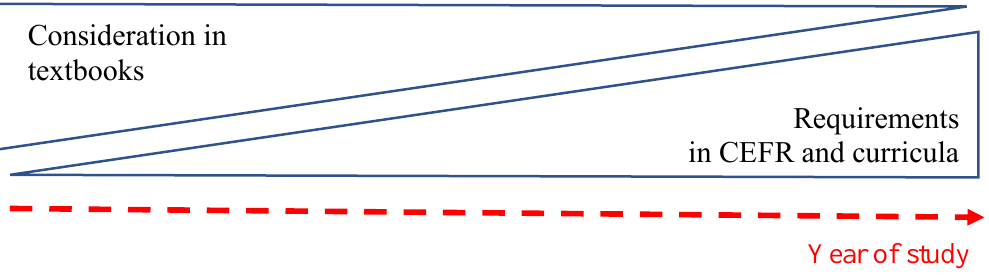
Figure 1. Contrary course between increasing requirements in CEFR and the curricula and increasing consideration of intonation in textbooks for teaching French and Spanish in the German classroom